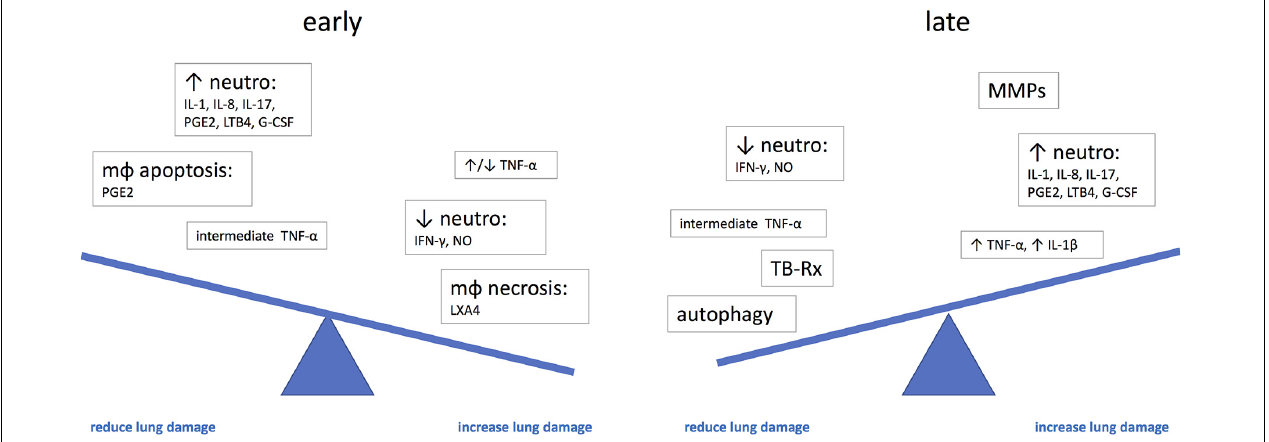
FIGURE 2 | The potential effect of immune mediators on the development of lung damage at different stages of disease. G-CSF, granulocyte-colony stimulating factor; IL, interleukin; LTB4, leukotriene B4; LXA4, lipoxin A4; m ϕ , macrophage; neutro, neutrophils; NO, nitric oxide; PGE2, prostaglandin E2; TNF, tumor necrosis